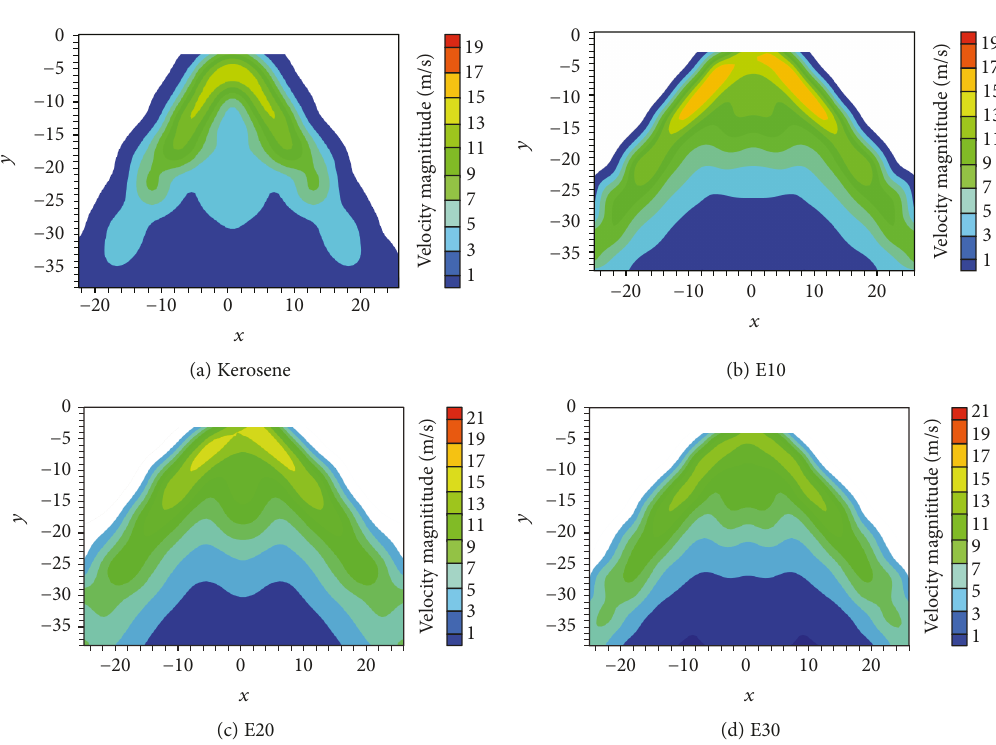
Figure 14: Velocity magnitudes at 0.5MPa.